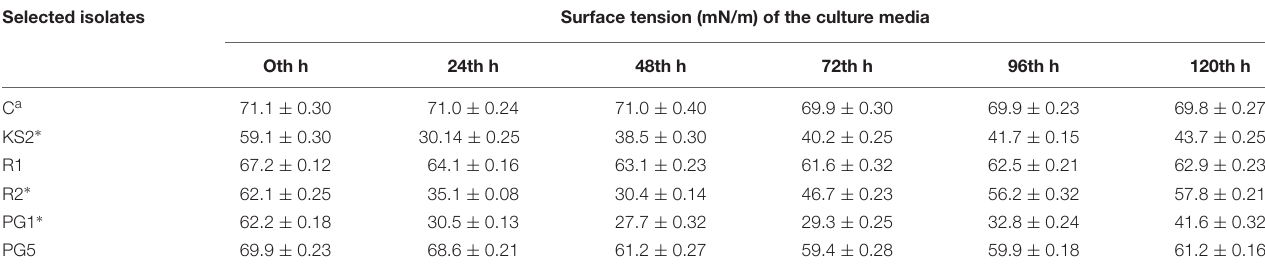
TABLE 1 | Surface tension (ST) measurements of the selected bacterial isolate on glucose-containing mineral medium at different time intervals. Selected